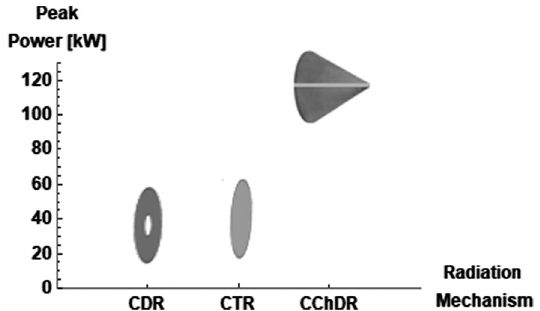
FIG. 10. Peak power of the CLEAR sub-THz source for the following electron beam parameters (per single bunch): 215 MeV, 1.5 ps, 40 pC. The experimental points have been represented by the sketch of the radiators corresponding to the different radiation